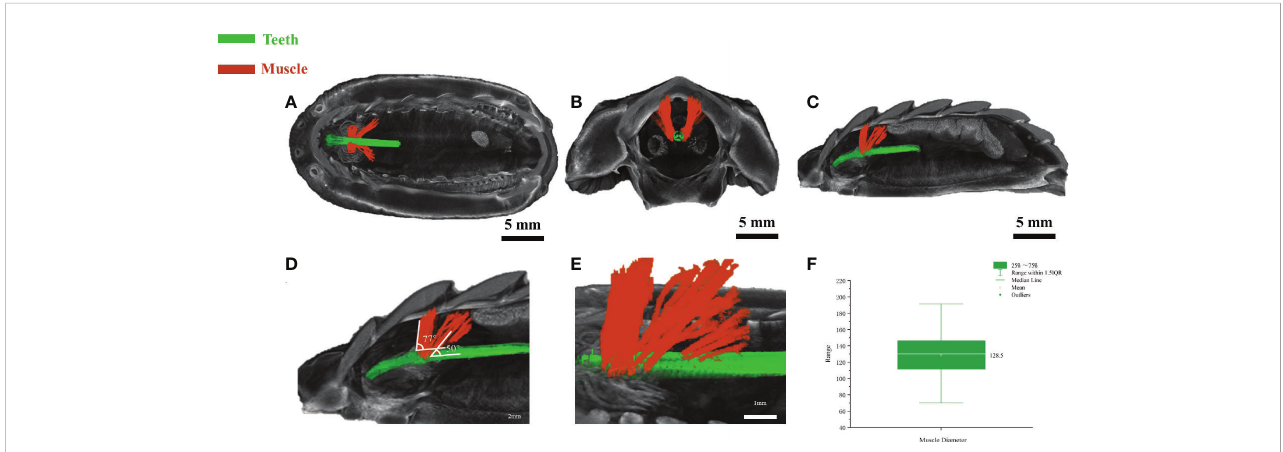
FIGURE 3 Soft-tissue micro-CT of radular muscles ex vivo. The bottom view (A) , coronal (B) , and the sagittal view (C) of the chiton. The magni fi ed image (D, E) of sagittal view highlighting the radula and muscle angles. (F) Statistical analysis of muscle diameter in the chiton (n=54). Green=radular teeth, orange=muscle. Soft-tissue micro-CT data of chiton Acanthochitona crinita was directly retrieved from the Morphobank database (https://morphobank. org/) with an accession number of 3107 (Ziegler et al.,